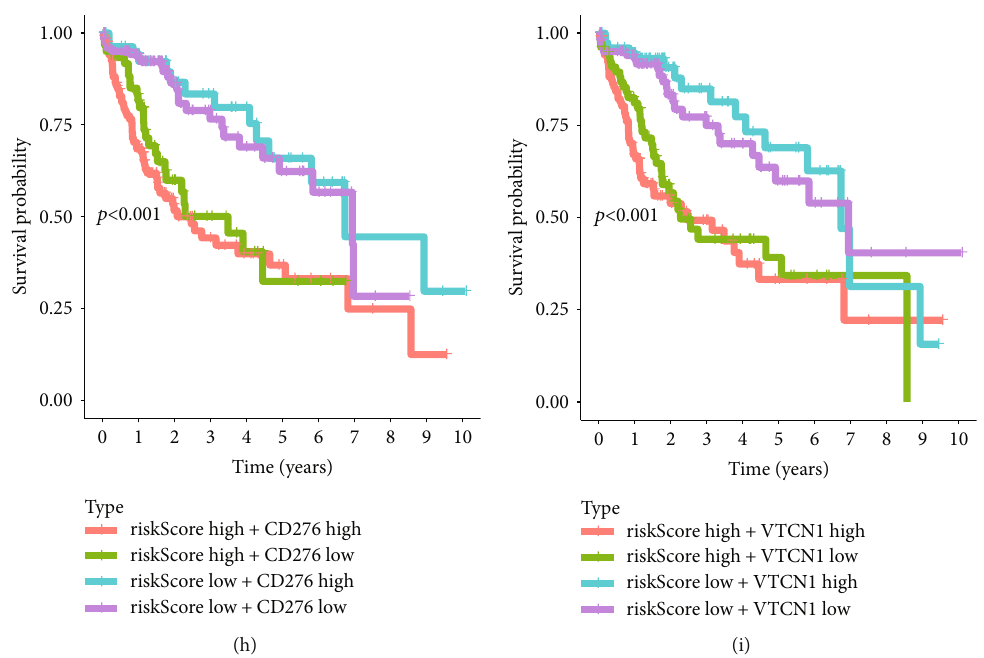
Figure 6: Survival analysis of HCC patients based on the risk score and several immune checkpoint molecules. (a) Correlation analysis between risk score and several key immune-related molecules. (b – i) Two-factor survival analyses of risk score and immune checkpoint molecules including PDCD1 (b), CTLA4 (c), CD80 (d), CD86 (e), CD274 (f), PDCD1LG2 (g), CD276 (h), and VTCN1